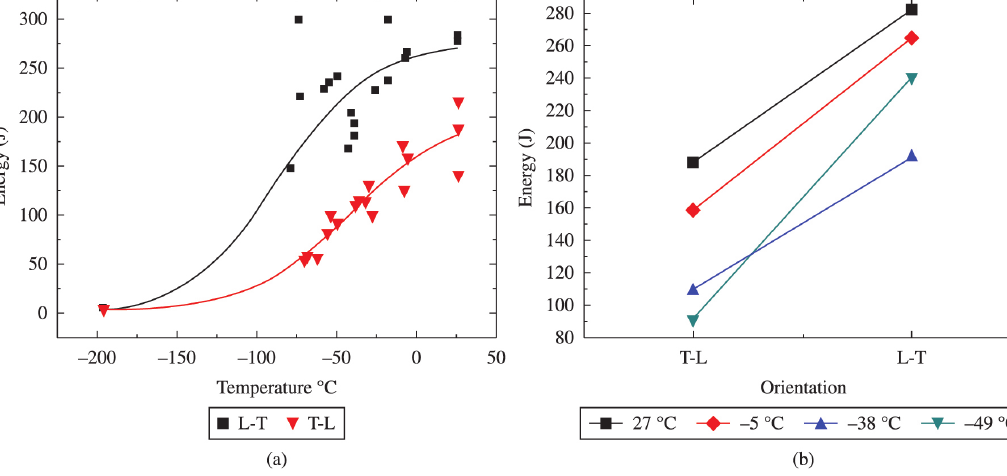
Figure 6. Charpy impact testing: a) as a function of temperature; b) as a function of the orientation (for some